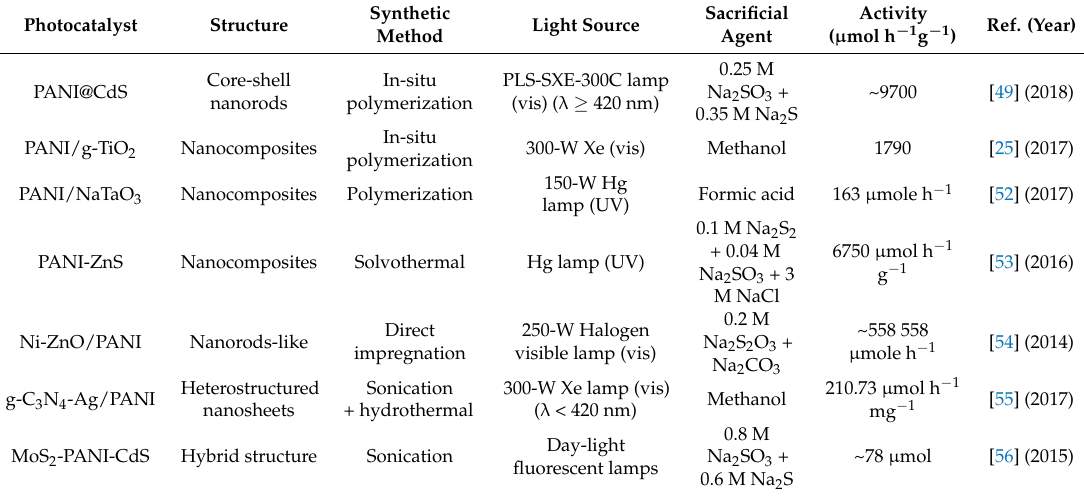
Table 4. Photocatalytic hydrogen activity of PANI based composite